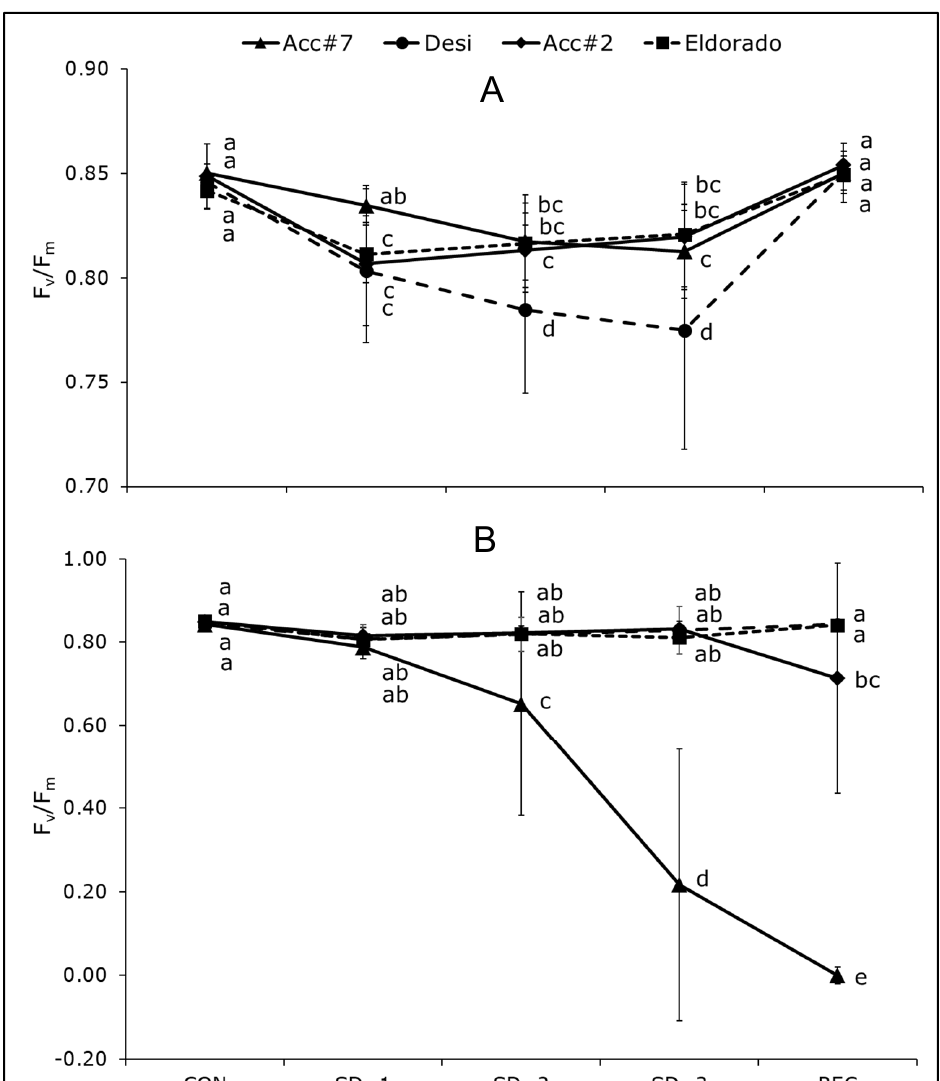
Figure 1. F v /F m by mini PAM in the second fully expanded top leaves of four chickpea genotypes under the treatments for 3 days. "CON", 25/20 °C day/night T; "SD − 1", after 24 h stress; "SD − 2", after 48 h stress, "SD − 3", after 72 h stress; "REC", after 48 h recovery time under control conditions. ( A Cold-stress treatment: 8/4 °C day/night; ( B ) Heat-stress treatment: 38/33 °C day/night. The data represent average values ± SD ( n = 8). Different small letters next to the point marks indicate significant differences ( p < 0.05.).